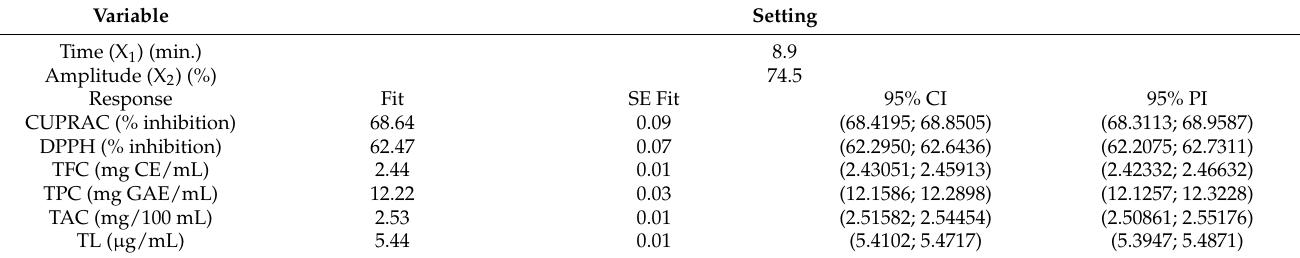
Table 3. Maximum optimization values according to RSM.